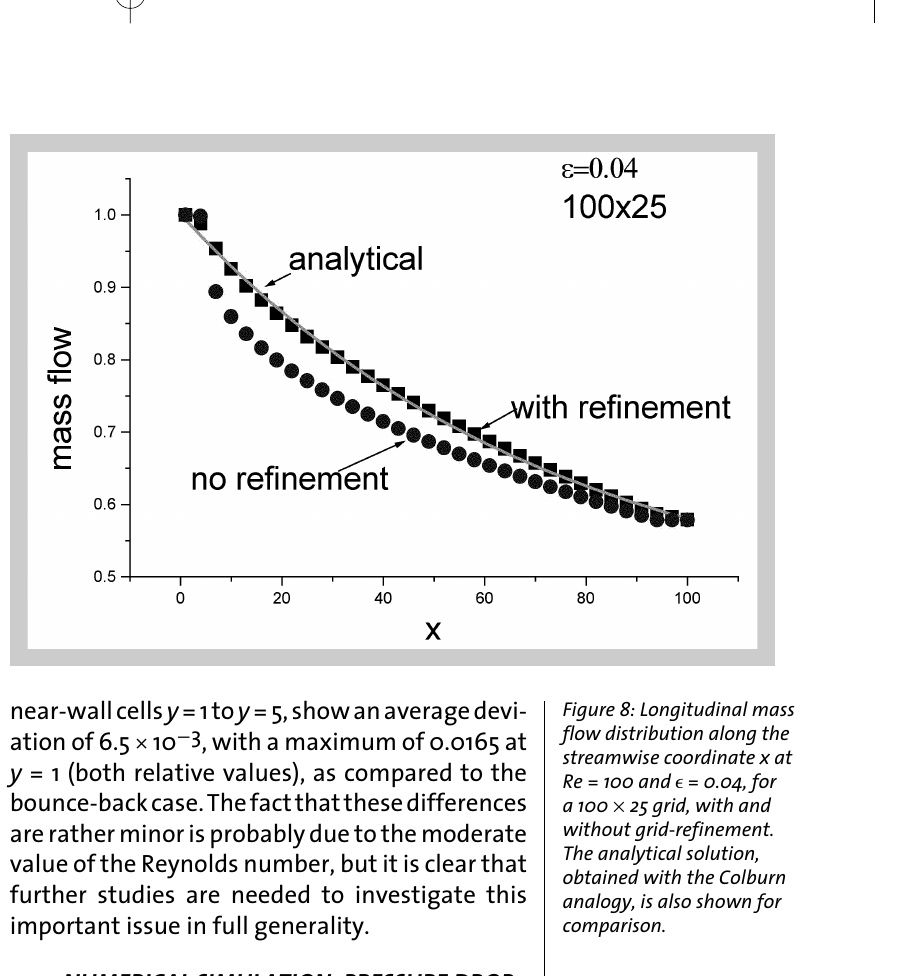
Figure 8: Longitudinal mass flow distribution along the streamwise coordinate x at Re = 100 and e = 0.04, for a 100 ¥ 25 grid, with and without grid-refinement. The analytical solution, obtained with the Colburn analogy, is also shown for